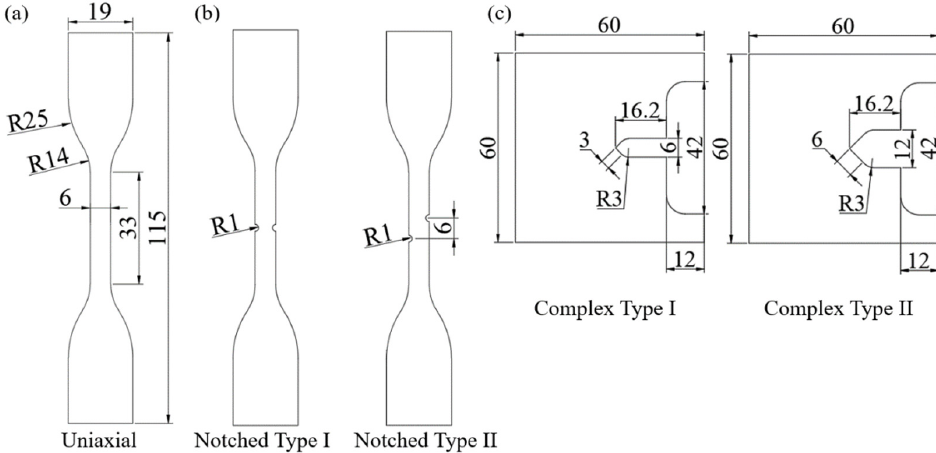
Figure 2. Dimensional specifications of test specimens denoted in mm. ( a ) ASTM-D638 Type IV standard uniaxial specimen. ( b ) Notched specimens. ( c ) Complex specimens.